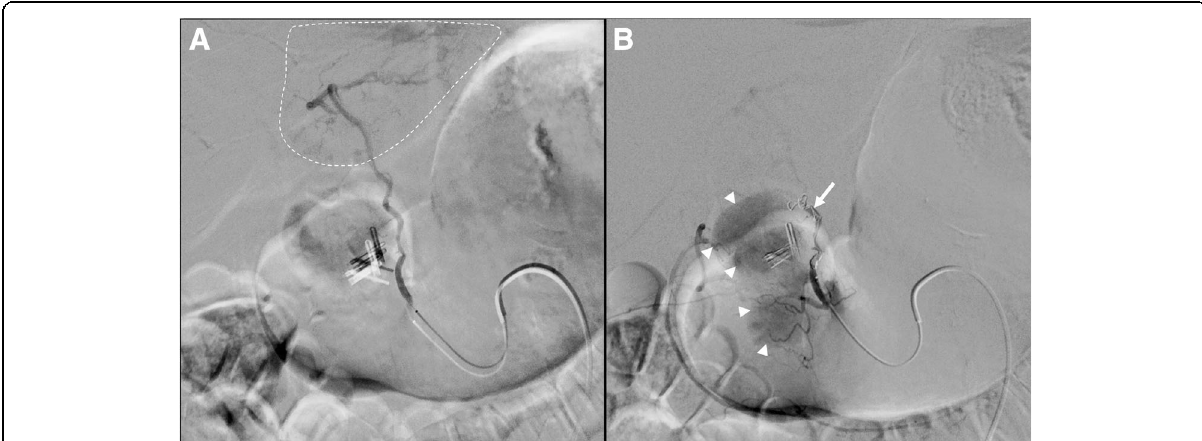
Fig. 3 a GDA angiographic subselection demonstrating blood supply to the left lobe of the liver (dotted area), with no opacification of the RHA . b Active extravasation of contrast into the duodenal lumen in the region of the endoscopic clips was seen (arrowheads). There is decreased distal flow after initial coil placement (arrow). Additional coils were subsequently